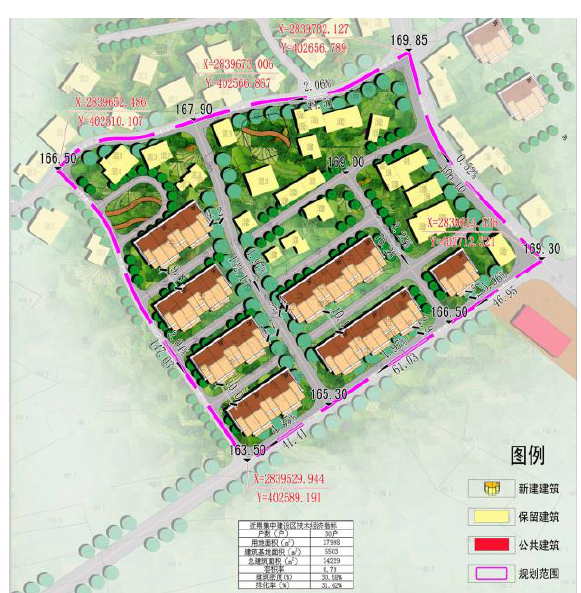
Figure 9. Plan of the rejected proposal. Source: courtesy of the local